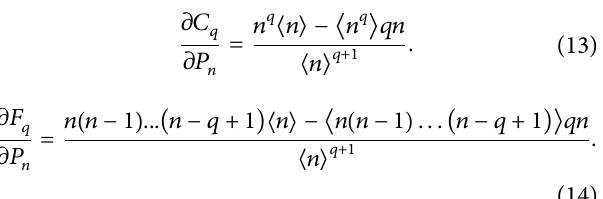
Figure 13: Normalized factorial moments F at different energies and in two pseudo-rapidity bins, | η | < 0.5 and